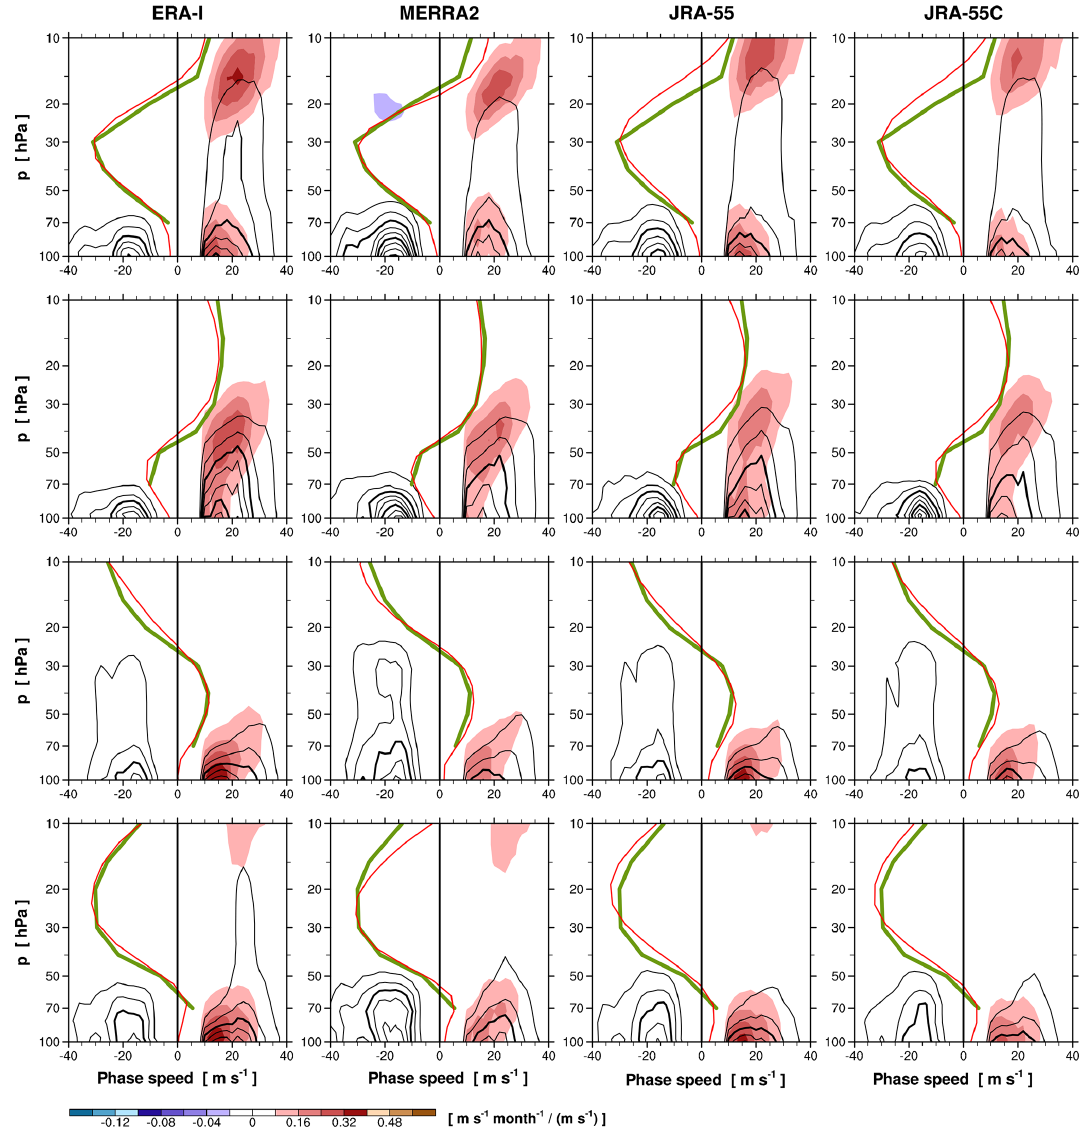
Figure 12. The same as in Fig. 11 except for the vertical divergence of the EP flux